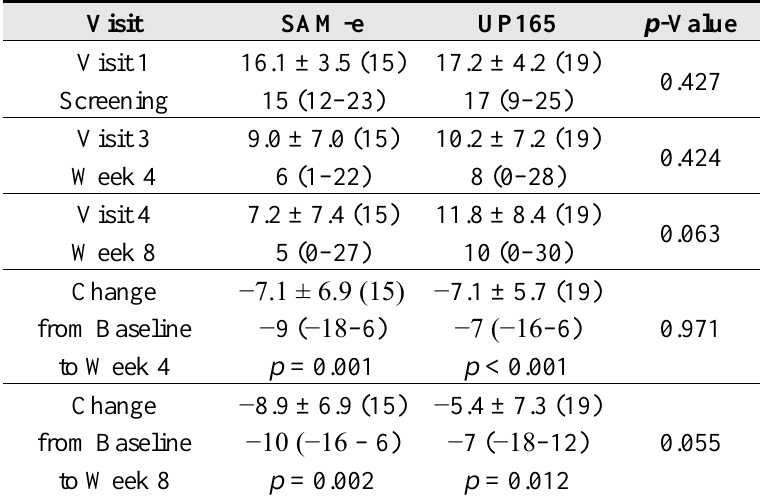
Table 2. BDI-II: Beck Depression